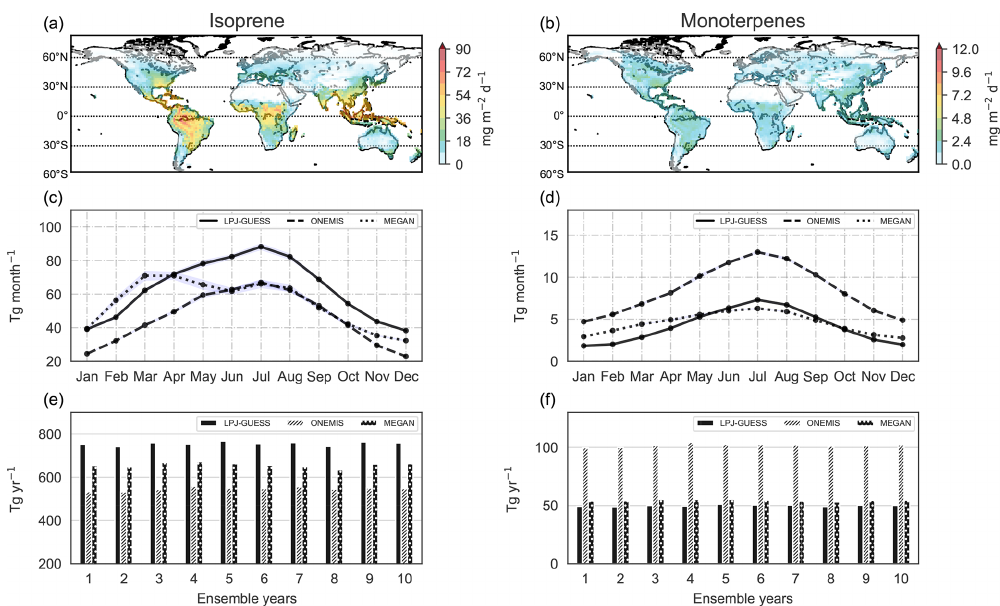
Figure 10. Spatial distribution of isoprene and monoterpene emissions from LPJ-GUESS at a spatial resolution of T63 (panels a and b ). Isoprene and monoterpene mean monthly totals in teragrams per month from LPJ-GUESS, ONEMIS and MEGAN (panels c and d ) and annual totals in teragrams per year for 10 ensemble years (panels e and f